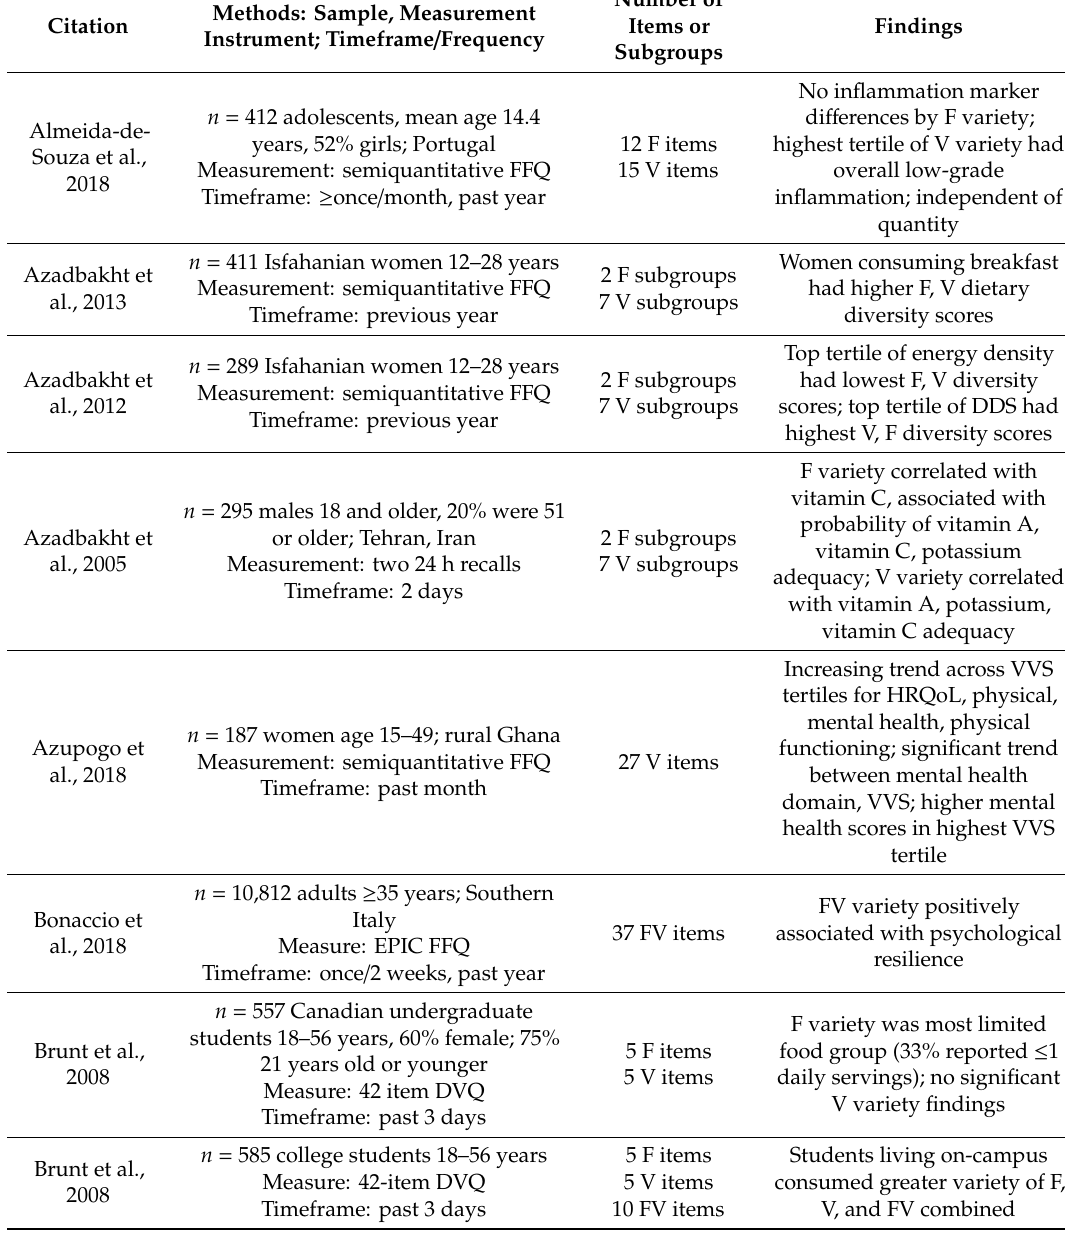
Table 3. Studies, from the literature, reported as cross-sectional design studies assessing fruit and vegetable (FV)